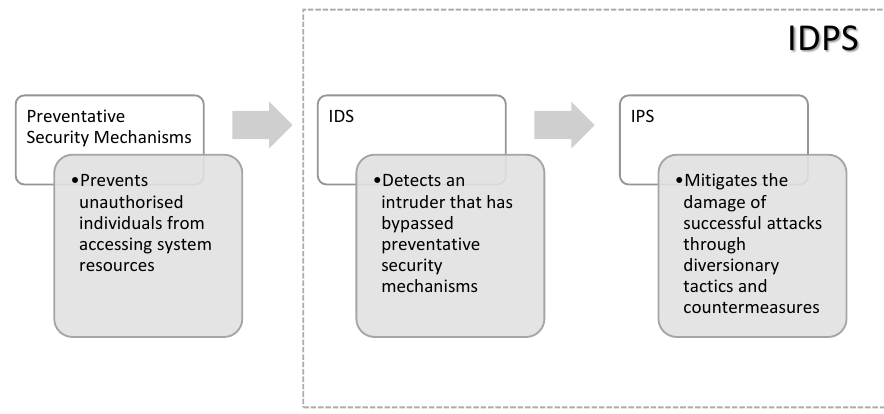
Figure 1. Security mechanisms that protect system